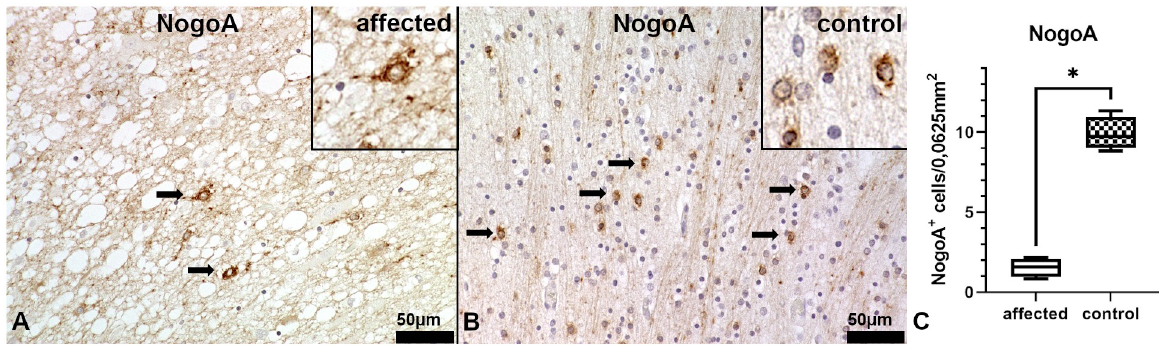
Fig 6. Immunohistochemistry of the white matter in the centrum semiovale of the cerebrum. (A) Affected puppy no. 1 and (B) age matched healthy control no. 1009. (A) In affected puppies, only single NogoA + oligodendrocytes are detectable (arrows). Vacuolization and loosening of the parenchyma indicate the moderate edema. Inset shows a NogoA + oligodendrocyte at a higher magnification. (NogoA). (B) Age matched control animals show numerous NogoA + myelinating oligodendrocytes. Inset shows NogoA + oligodendrocytes at a higher magnification. (NogoA). (C) Statistical analysis of NogoA-immunohistochemstry shows significantly decreased numbers of myelinating oligodendrocytes in the centrum semiovale of the affected Schnauzer puppies (n = 4, no.1, 2, 3 and 4) in comparison to age matched control animals (n = 4, no. 1009, 1010, 1011 and 1012). Box and whisker plots display median and quartiles with maximum and minimum values. Significant difference ( p � 0.05, Mann- Whitney U-test) is labeled by